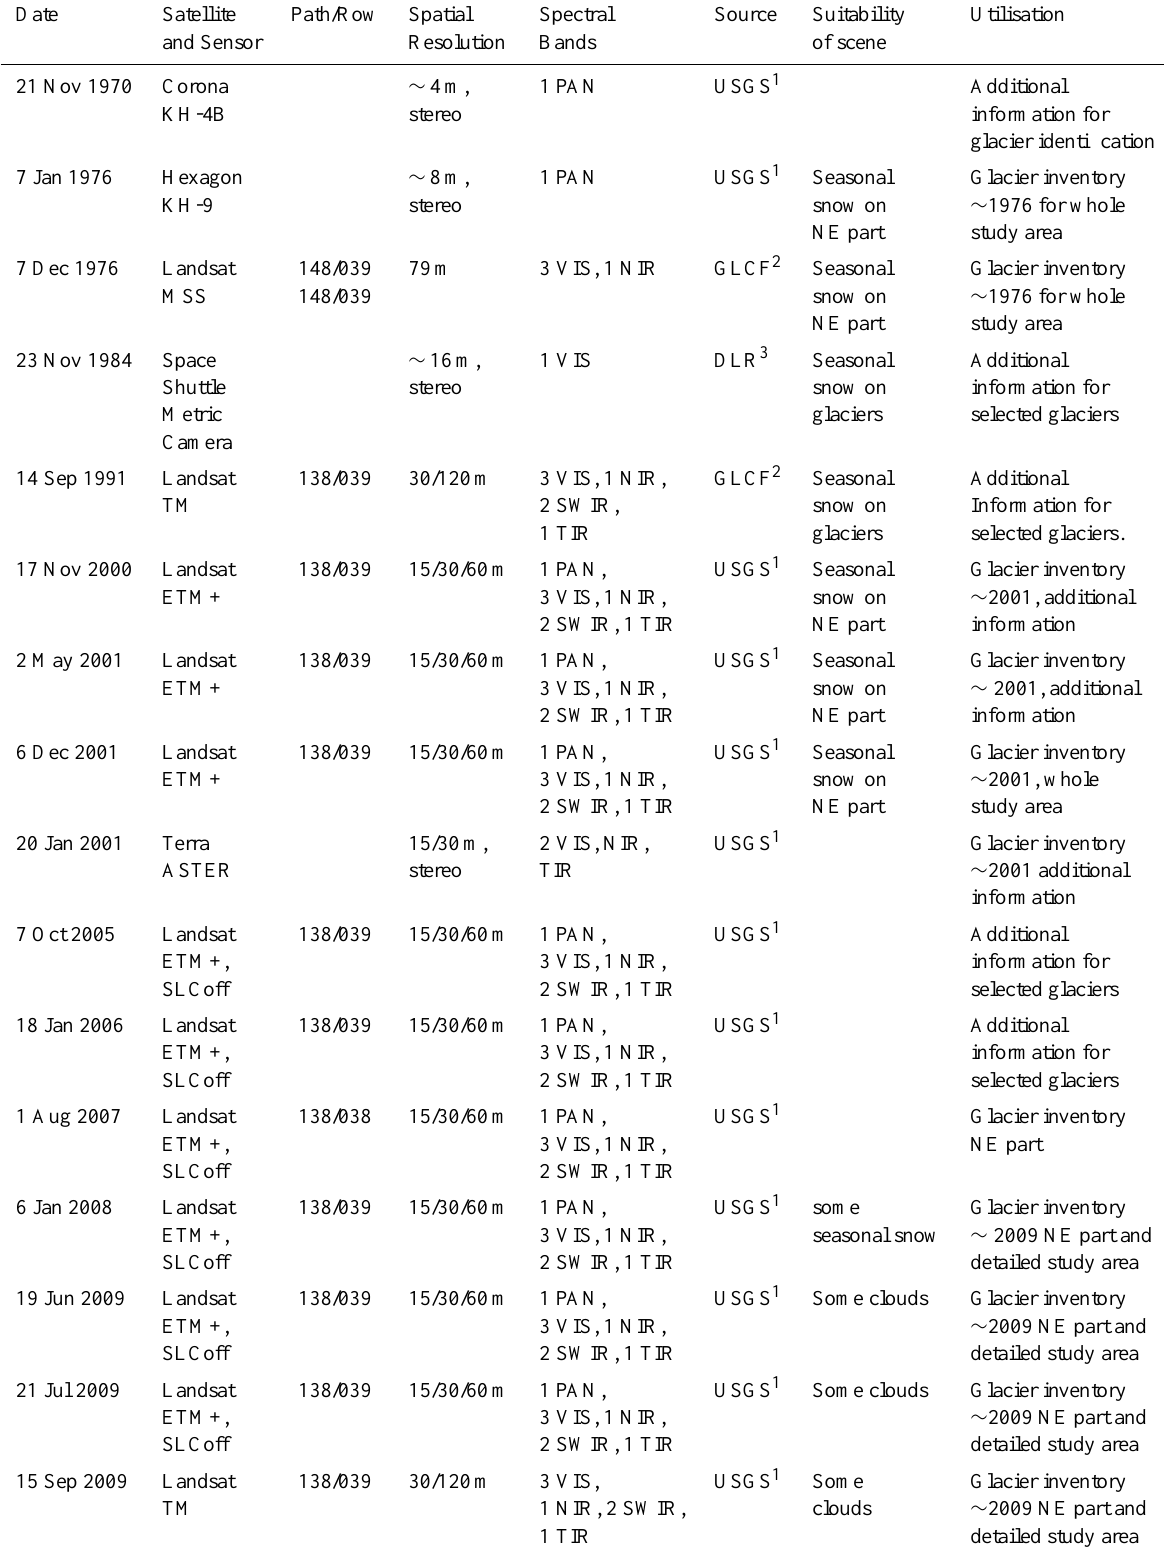
Table 1. Utilized space